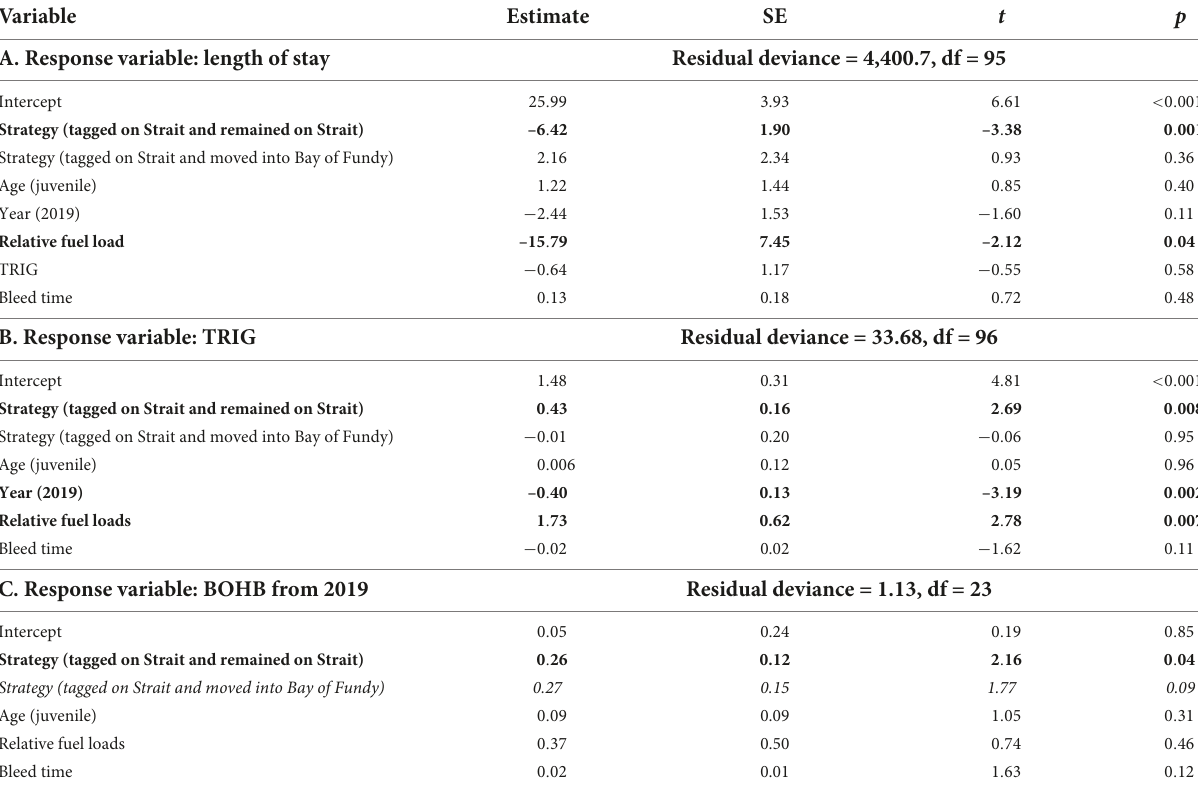
TABLE 4 Generalized linear models analyzing plasma triglycerides (TRIG) in tagged birds.